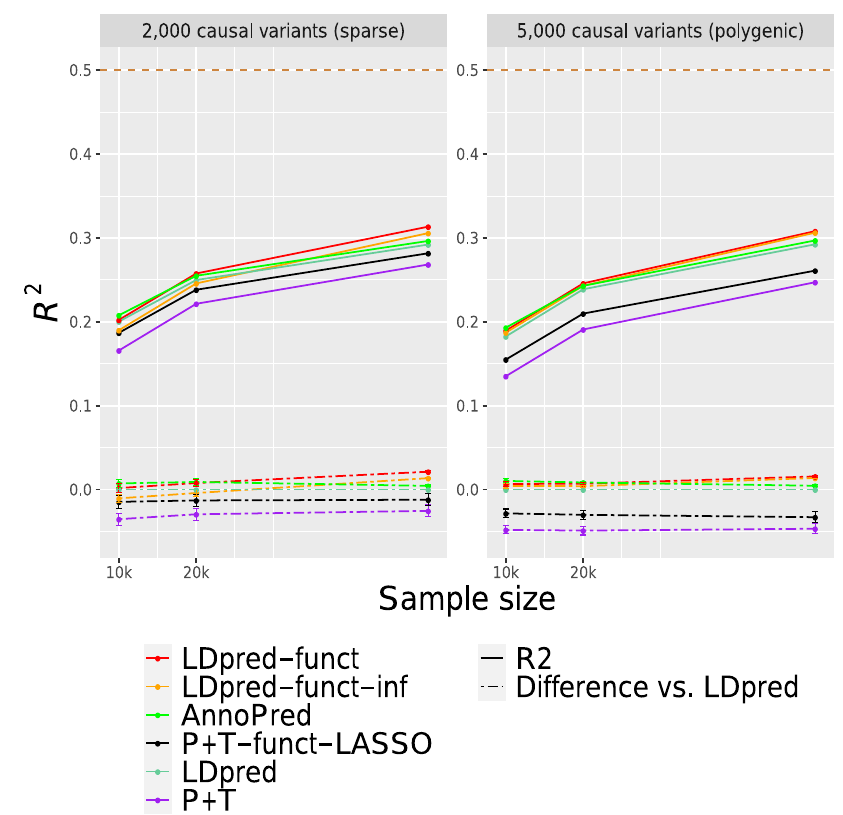
Fig. 1 Accuracy of 6 polygenic prediction methods in simulations using UK Biobank genotypes. We report results for P + T, LDpred, P + T-funct-LASSO, AnnoPred, LDpred-funct-inf, and LDpred-funct in chromosome 1 simulations with 2000 causal variants (sparse architecture) and 5000 causal variants (polygenic architecture). Results are presented mean R 2 values averaged across 100 simulations. Bottom dashed lines denote differences vs. LDpred; error bars represent 95% con fi dence intervals. The top dashed line denotes simulated SNP-heritability of 0.5. Results for other values of the number of causal variants are reported in Supplementary Fig. 1, and numerical results are reported in Supplementary Tables 1 and 2. Source data are provided as a Source Data fi